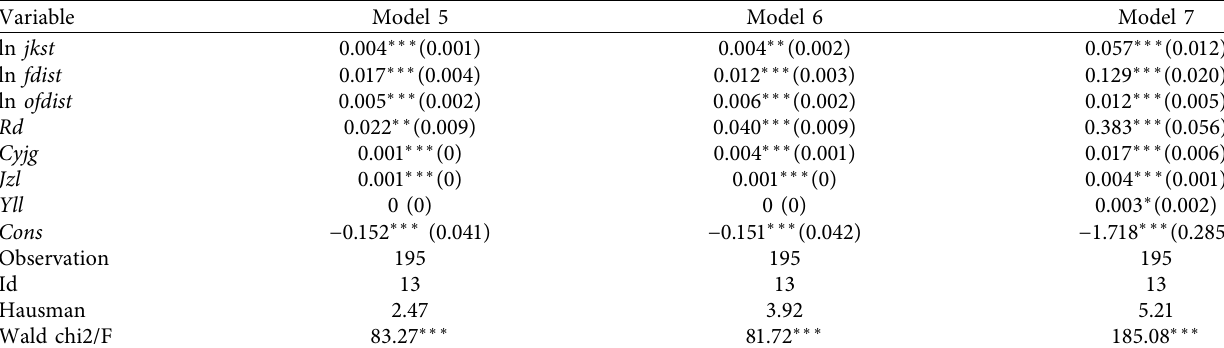
Table 7: Variable robustness